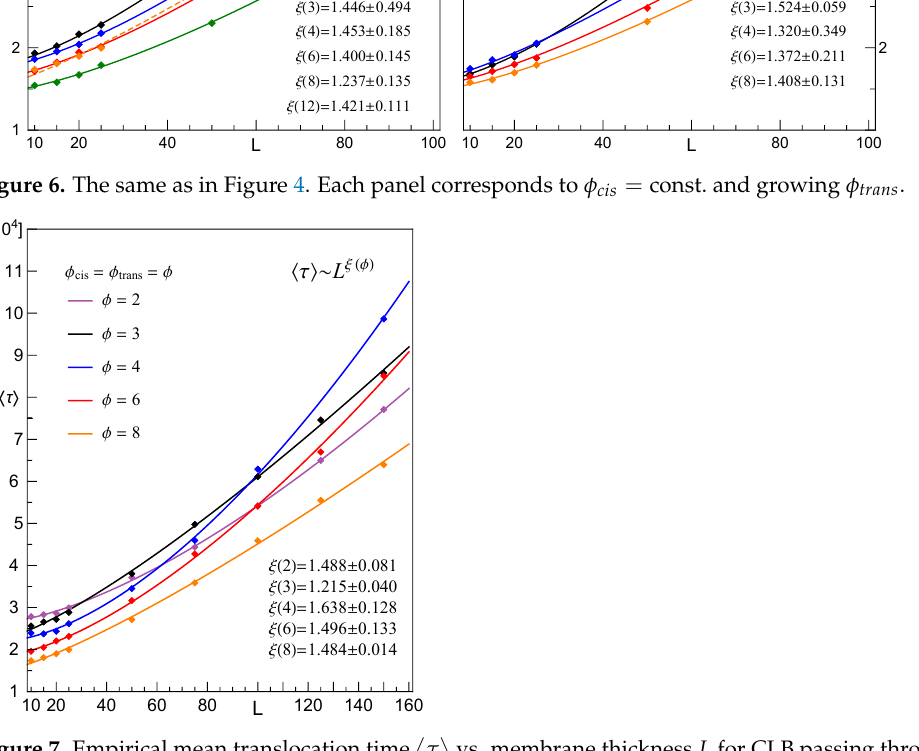
Figure 7. Empirical mean translocation time cylindrical pores with exemplary values of φ